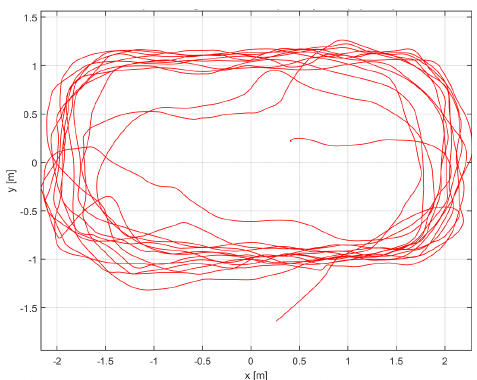
Figure 2. UAV position tracked by the MoCap system. Fig. 3 shows a comparison of the reference UAV trajectory with that obtained by means of the UAV system (in the EKF1 case).